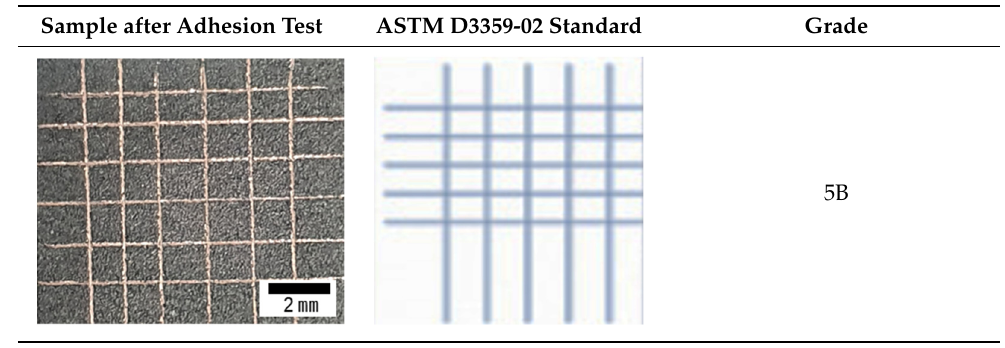
Figure 3. The cross-sectional images at ( a ) high- and ( b ) low-magnification with ( c ) EDS mapping. Table 1. Adhesion tests according to ASTM D-3359-02 on the copper coating surface. Sample after Adhesion Test